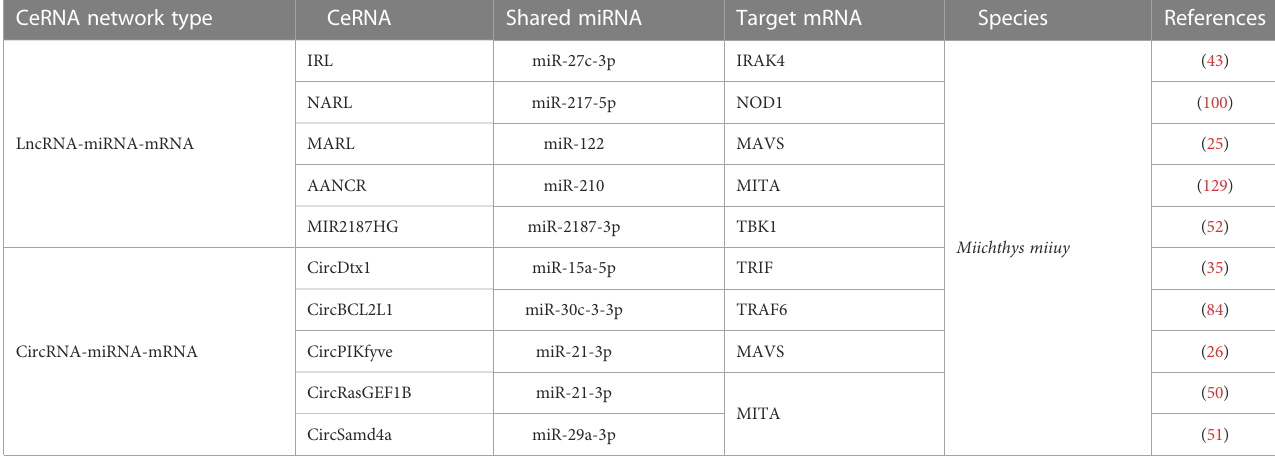
TABLE 5 Summary of identi fi ed competing endogenous RNAs (ceRNAs) associated with genes of the nuclear factor-kappa B (NF- k B) pathways in aquatic animals. CeRNA network type